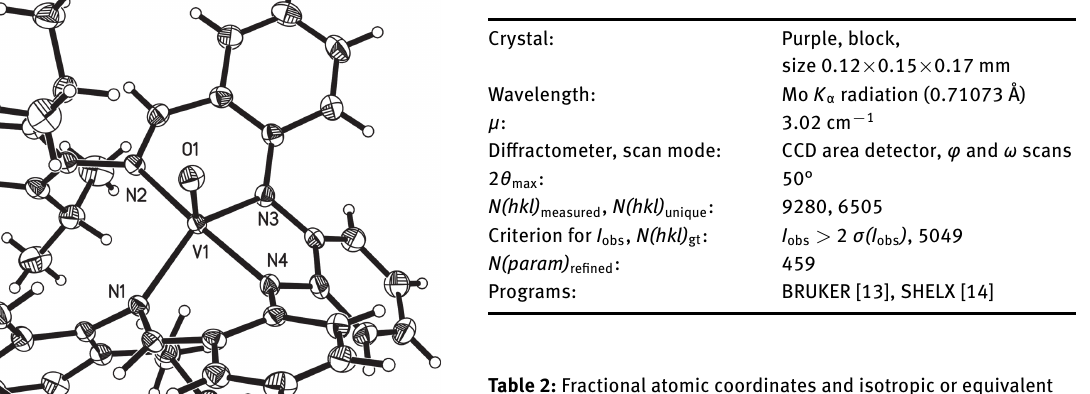
Table 2: Fractional atomic coordinates and isotropic or equivalent isotropic displacement parameters (Å 2